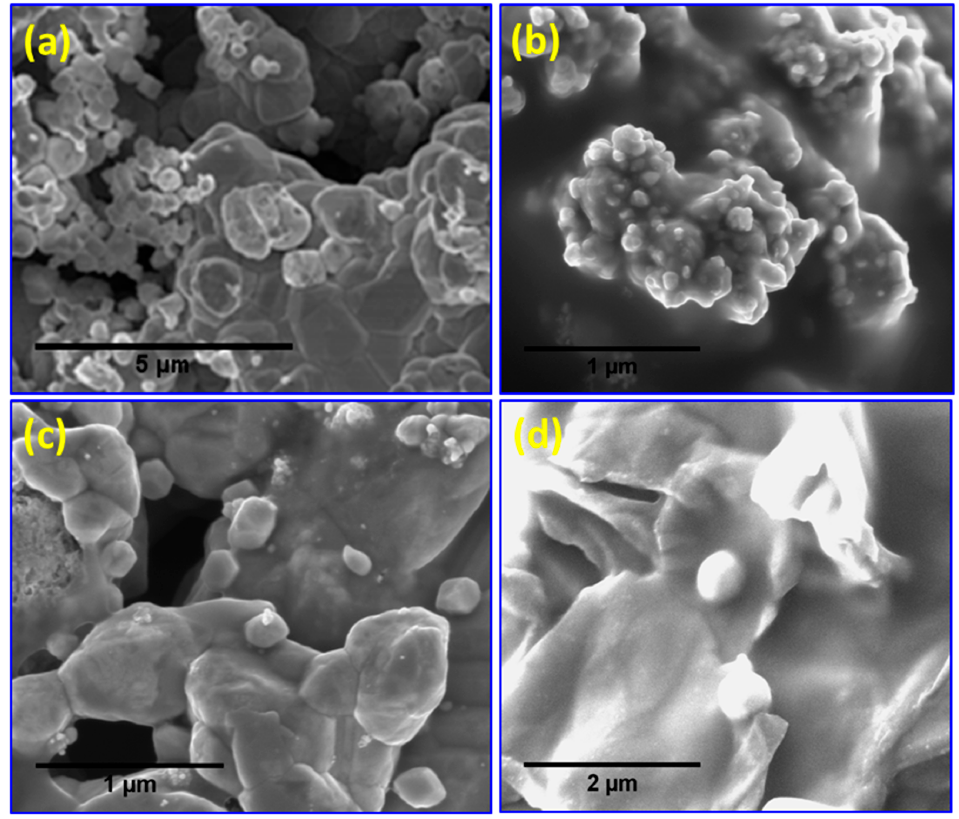
Figure 6. SEM micrographs of ( a ) AgNPs and ( b ) PS/AgNPs; ( c ) PMMA/AgNPs; and ( d ) PSMMA/AgNPs